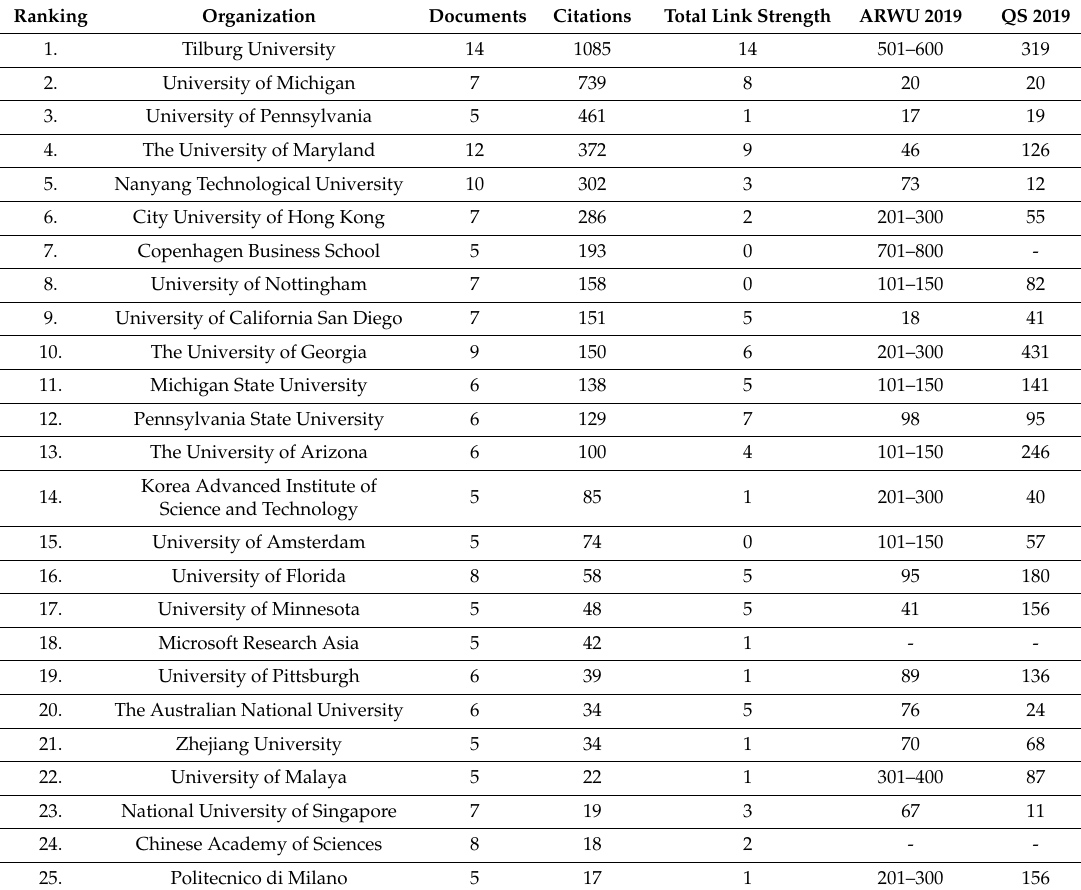
Table 3. Top 25 International Collaborations / Organizations and Record Count. Minimum number of documents of a country (5) and minimum number of citations of a country